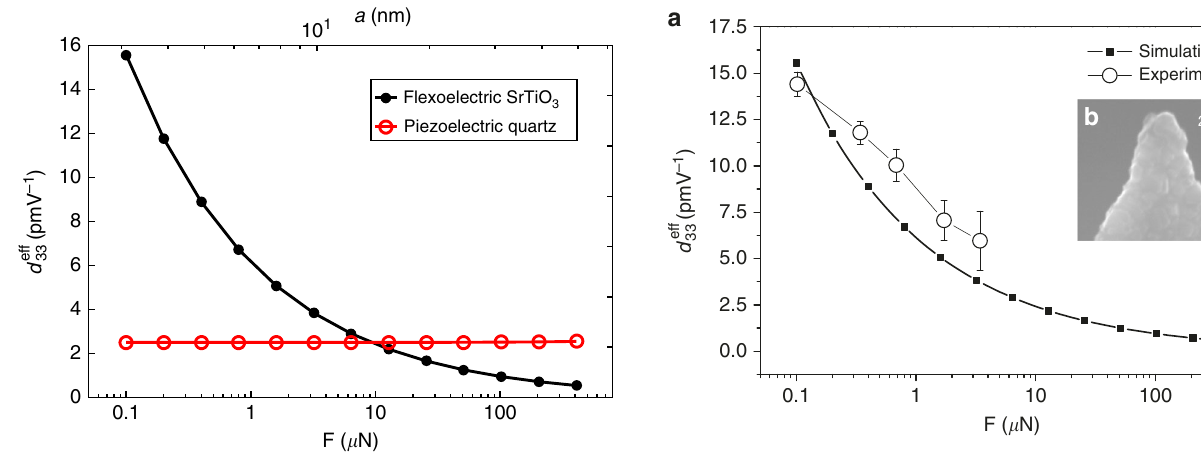
¼ Δ u = V , where Δ u z z 33